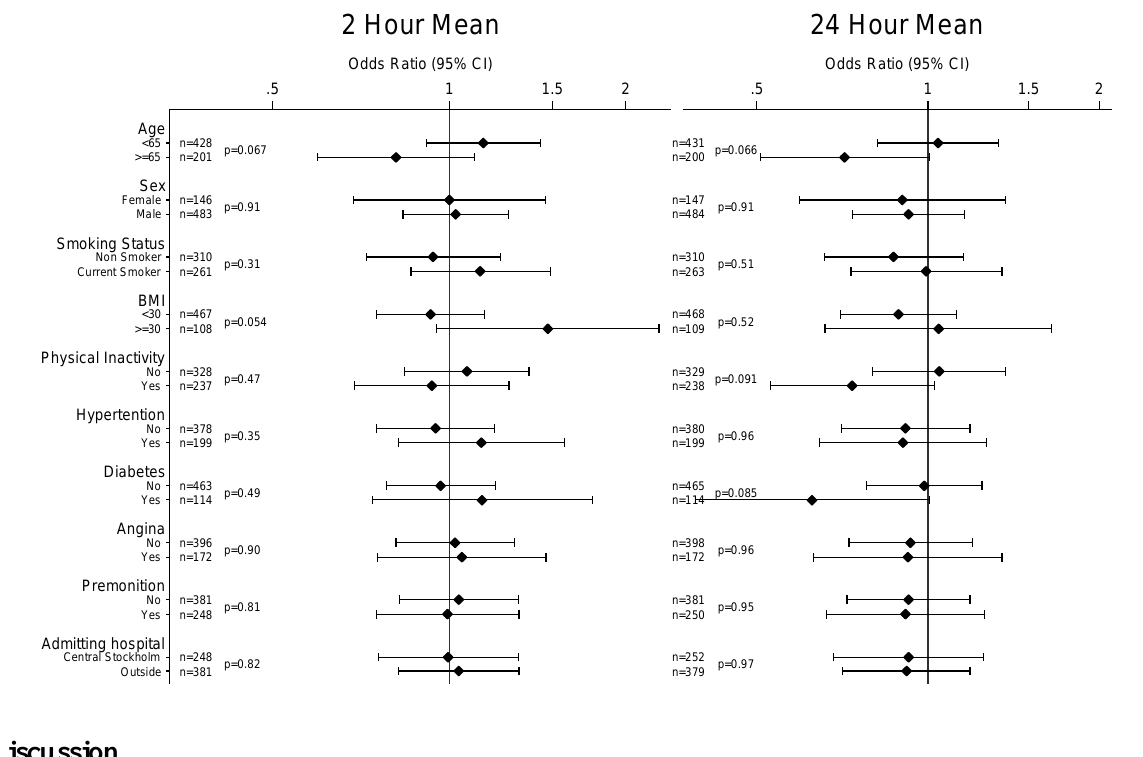
Figure 4. Odds ratios of myocardial infarction for an interquartile range increase in 2 h and 24 h moving averages of O in different subgroups (P-values for interaction). Number of 3 observations for each subgroup with complete data on analyzed covariate and air pollution indicated by